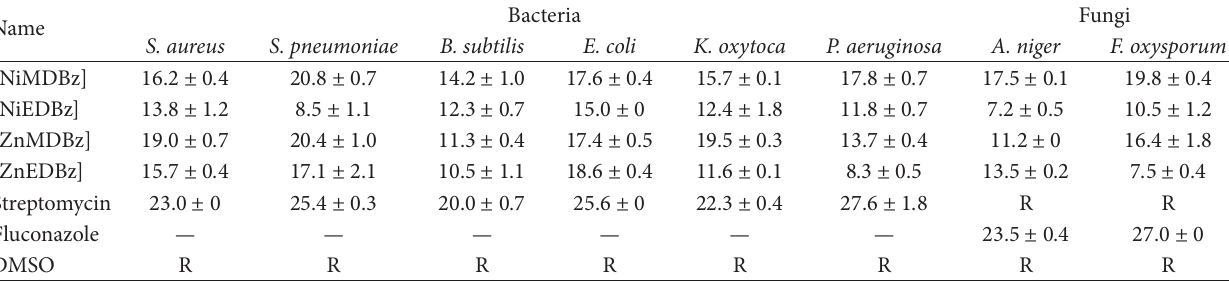
Table 3: A summary of the antimicrobial activities of the mixed-ligand complexes.